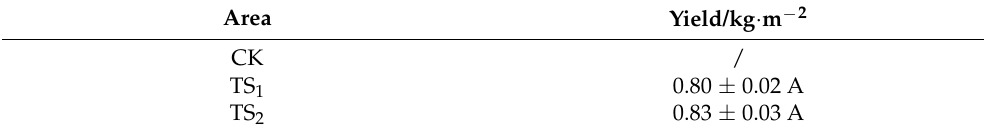
Table 6. Effects of WCTRZSCS on tomato yield. Area